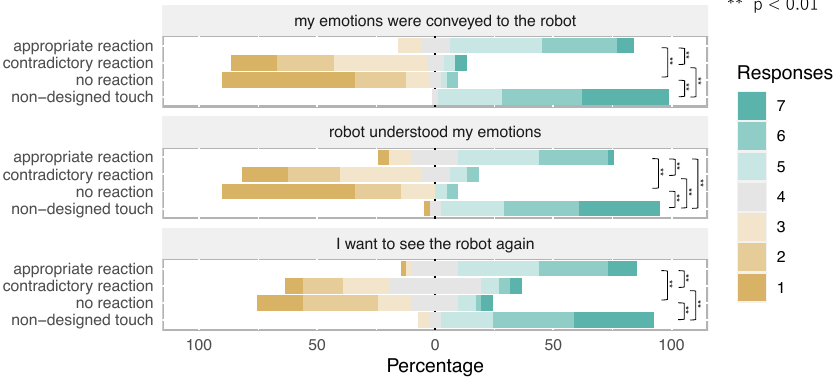
Figure 8. Results of questionnaire responses after each session (4/4): impressions of the